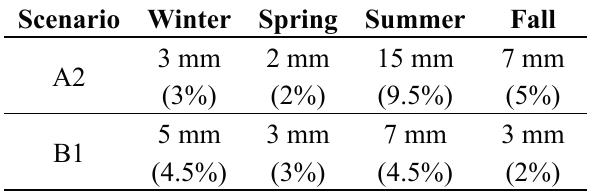
Table 2. Projected change in mean seasonal precipitations under the A2 and B1 scenarios for the long-term period (2020–2040) with respect to the mean seasonal precipitations under the reference period (2000–2011). The values within the parentheses are relative